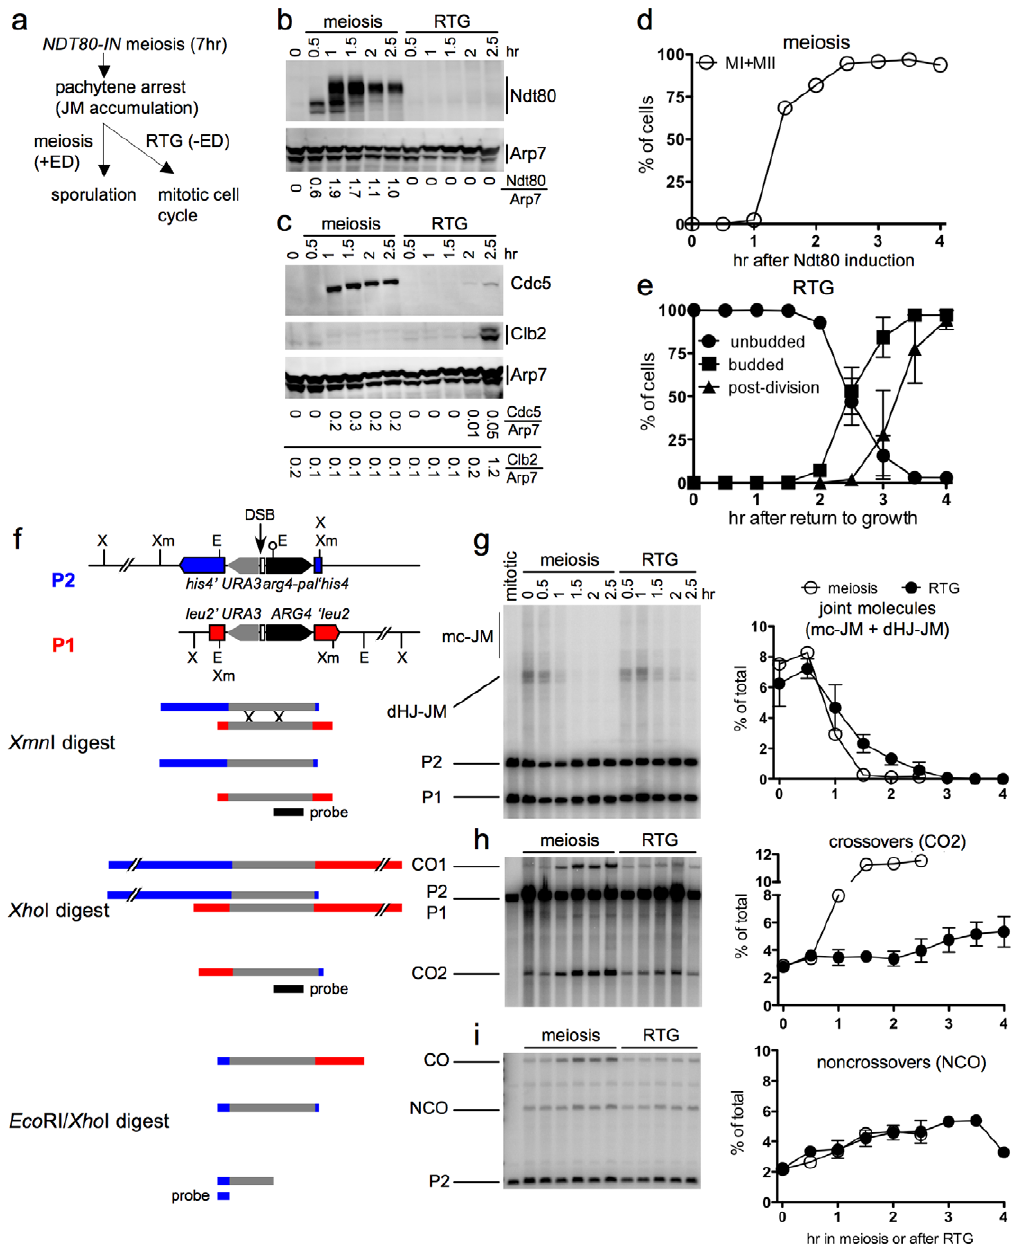
Figure 4. JM resolution and recombinant product formation during meiosis and RTG. a. Experimental design. Cells with an estrogen- inducible NDT80 allele (MJL3430) are incubated in sporulation medium for 7 hr to uniform pachytene arrest. Estradiol (ED) is added to half of the culture to induce NDT80 expression and the completion of meiosis, while the other half is transferred to YPD to undergo RTG in the absence of NDT80 expression. b. Western blot showing Ndt80 production after addition of ED (meiosis) or after RTG. Arp7 is used as a loading control. Relative Ndt80 levels (arbitrary units) are shown below each lane. c. Western blot showing production of Ndt80-regulated polo-like kinase, Cdc5, and of the G2/M cyclin, Clb2, which is not expressed during meiosis. Arp7 is used as loading control. Relative protein levels (arbitrary units) are shown below each lane. d. Meiotic progression after NDT80 induction by ED addition. The percentage of cells completing meiosis I in a single experiment was determined by DAPI staining and counting the fraction of cells with more than one nucleus (MI + MII). Values are from a single experiment. e. Cell cycle progression after RTG. Cell cycle events were scored as in Figure 1. Values are from three independent experiments. f. Recombination reporter system used to detect recombination intermediates and products [7]. A 3.5 Kb insert with the URA3 (grey) and ARG4 (black) genes is inserted at LEU2 (red) on one chromosome III homolog and at HIS4 (blue), 16.7 Kb away, on the other. 65 nt of yeast telomere sequences (open box), inserted between URA3 and ARG4 , create a strong meiotic DSB site (vertical arrow). A short palindrome containing an Eco RI site (lollipop) , 0.6 kb from the DSB site, creates the arg4-pal allele in the insert at his4 . Arrows denote the direction of transcription. Restrictions sites: Xm— Xmn I; X— Xho I; E— Eco RI. An Xmn I digest probed with ARG4 sequences (black bar) detects dHJ-JMs. A Xho I digest probed with the same sequences detects CO products. An Eco RI/ Xho I double digest, probed with HIS4 sequences (blue bar) detects NCO events where the arg4-pal allele is converted to ARG4 (full conversion shown), as well as a subset of COs (CO). It should be noted that a subset of NCOs are detected by this assay. Based on tetrad data from similar strains [7], we estimate that about 1/6 of total NCOs are detected. g–i. DNA was prepared from NDT80-IN cells (MJL3430) that were either induced to complete meiosis by ED addition or shifted to YPD to undergo RTG, as illustrated in a. Samples were analyzed for JMs, COs and NCOs as illustrated in f. Values for meiosis are